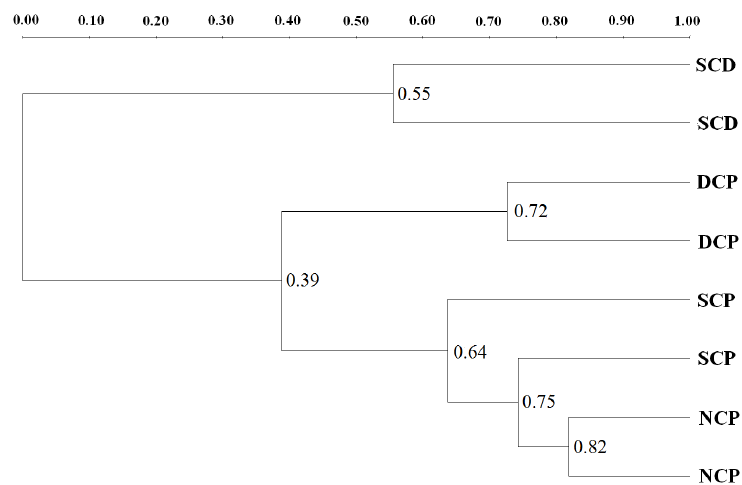
Figure 2. Cluster analysis of forest types by soil bacterial community.